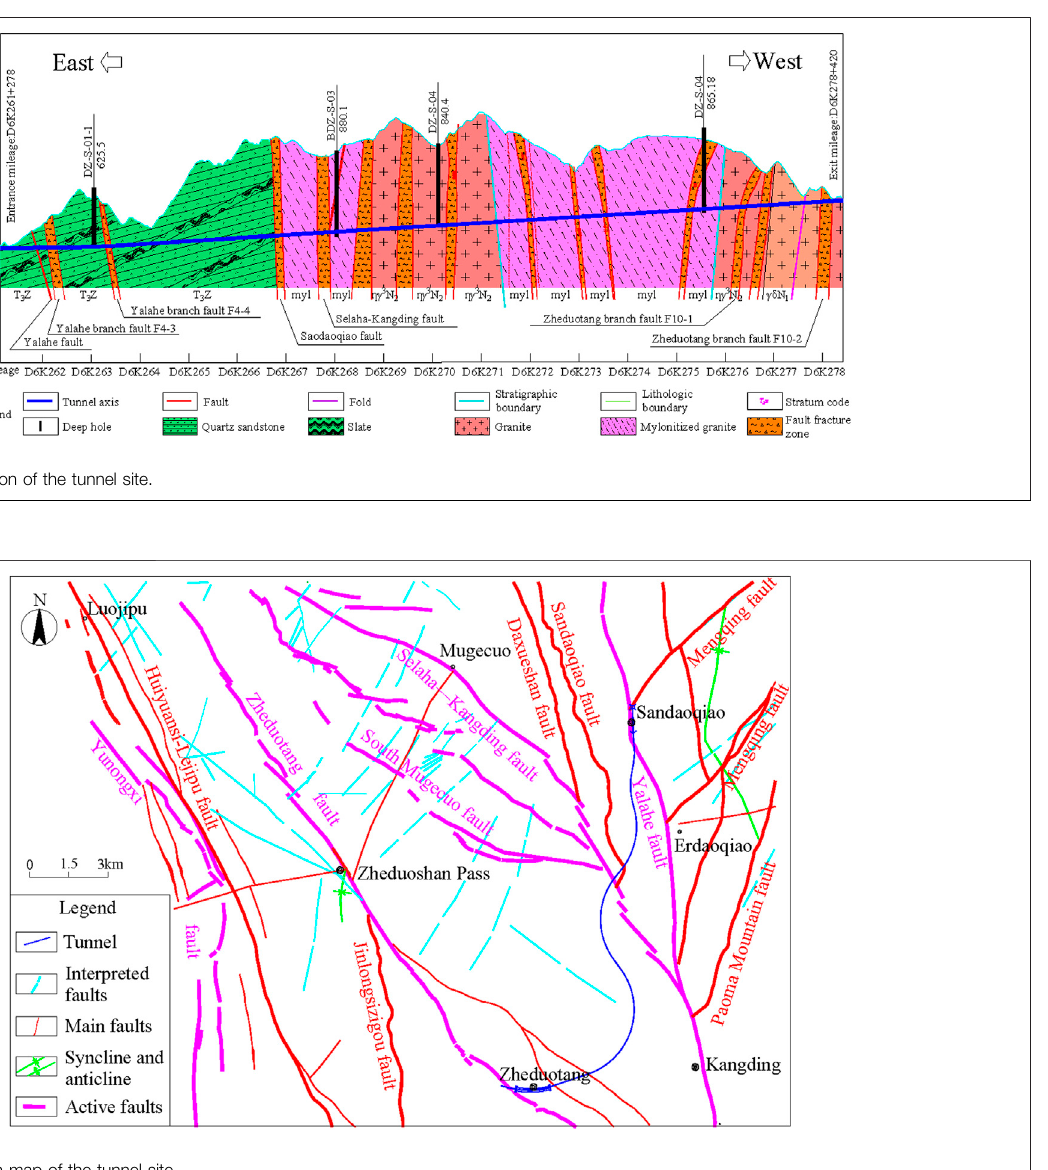
FIGURE 3 | Fault distribution map of the tunnel